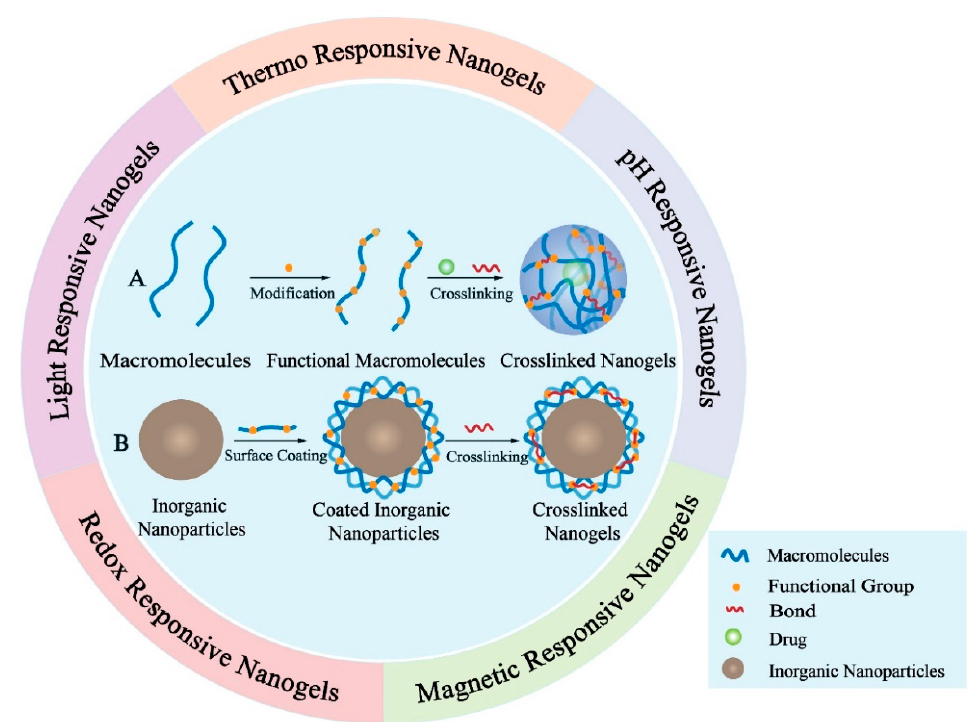
Figure 5. Schematic demonstration of nanogels. The inner circle illustrates the preparation of two representative crosslinked nanogels. ( A ) Preparation of macromolecules-based crosslinked nanogels; ( B ) Preparation of inorganic nanoparticles-based crosslinked nanogels. The outer circle demonstrates five typical stimuli-responsive nanogels. The drugs encapsulated will be released from nanogels after triggered by different stimulus like temperature, pH value, magnetic field, redox potential and light.